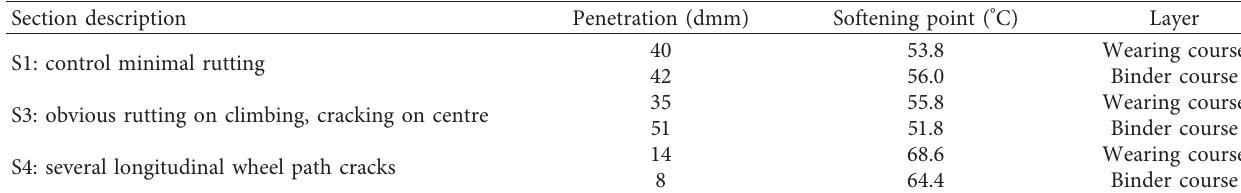
Table 8: Penetration and Softening Point of recovered bitumen.